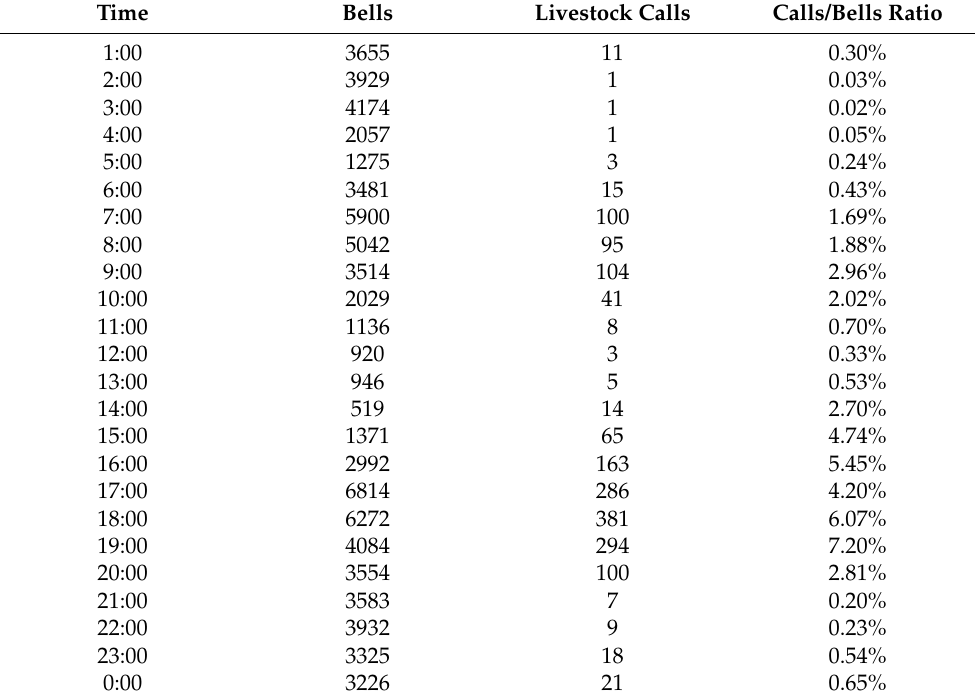
Table 2. Diel calling activity of livestock across all sites and for the duration of the survey period as deduced by the ratio of livestock calls to bell rings.